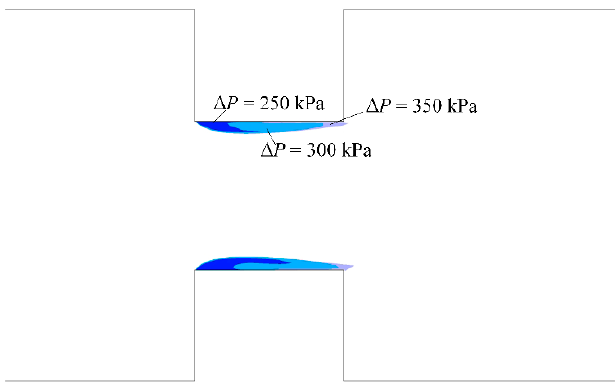
Figure 7. Vapor volume fraction on the symmetry plane vs. different pressure differences with l / d = 1.0.